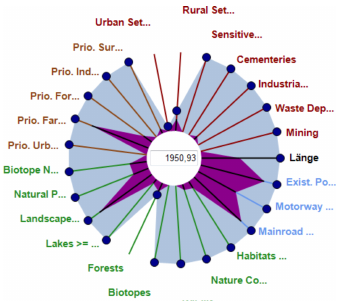
( b ) GIS View: Solutions with little impact on settlements and Forests Figure 4.